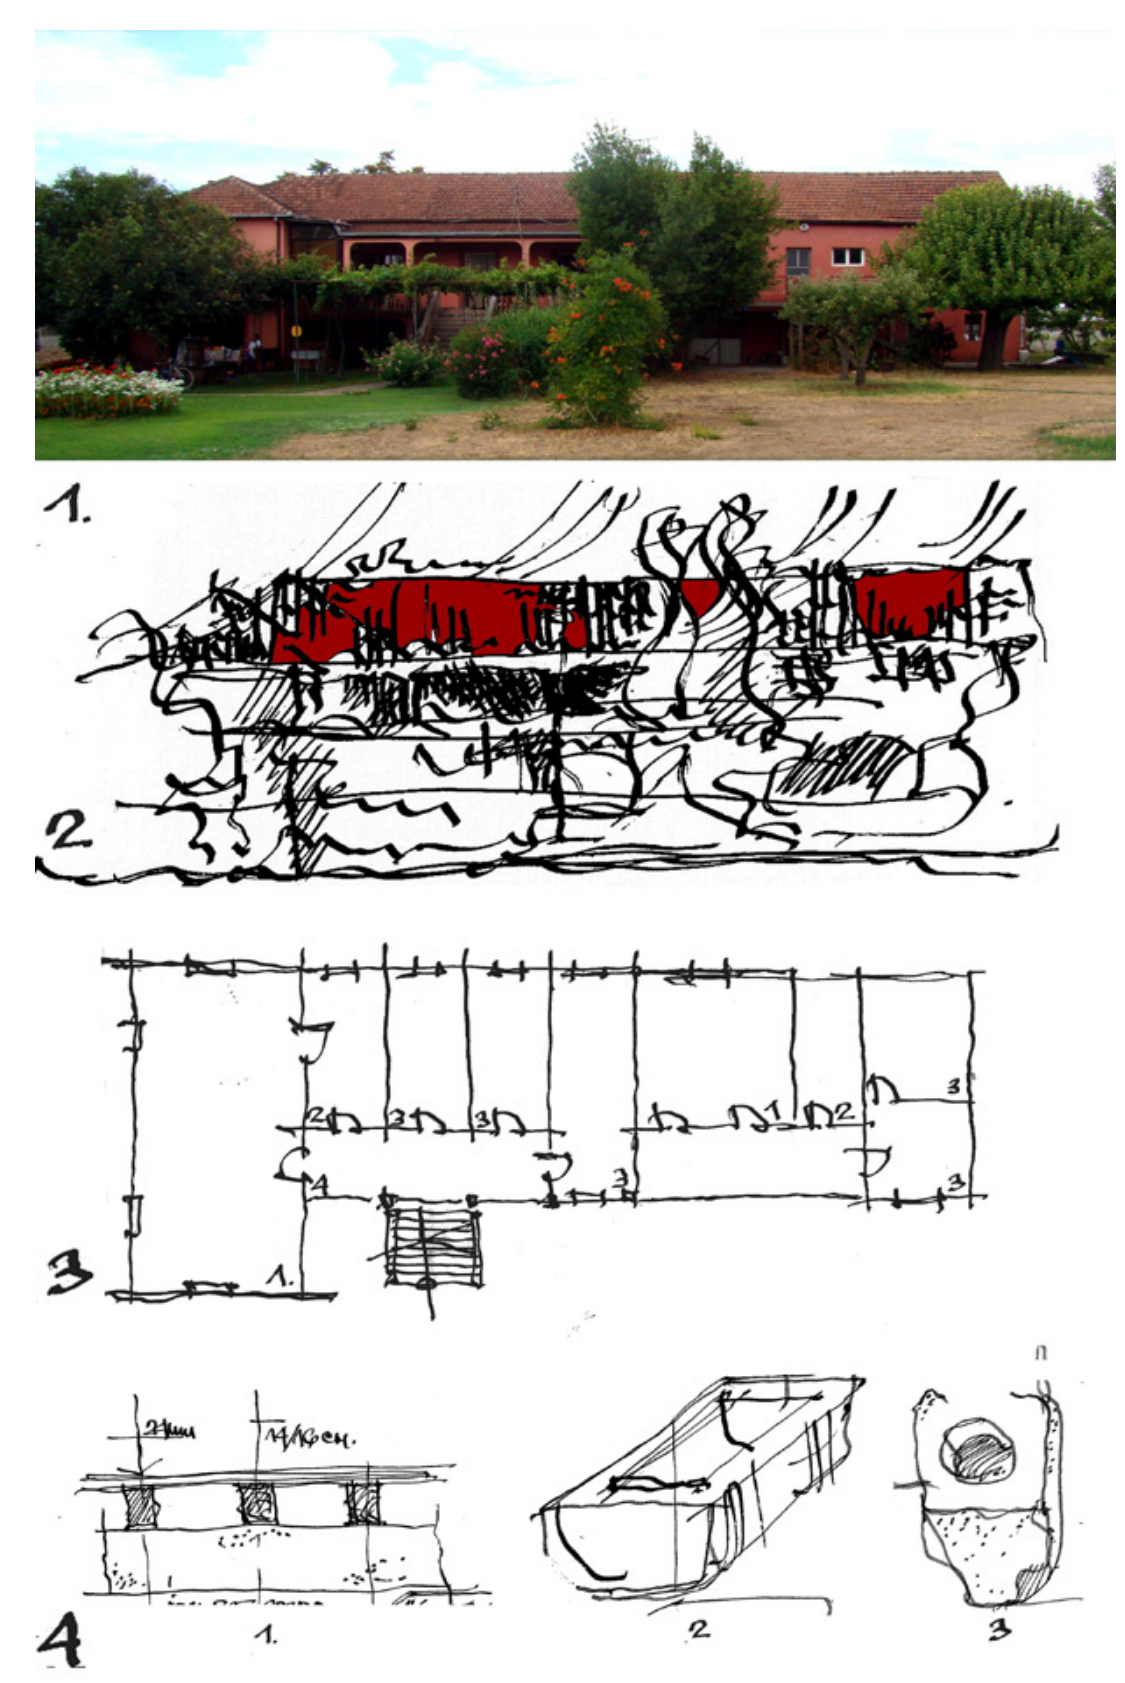
Figure 18. Photo and drawing of the House of Vujacic, Zeta region, (Photo G. Skataric).